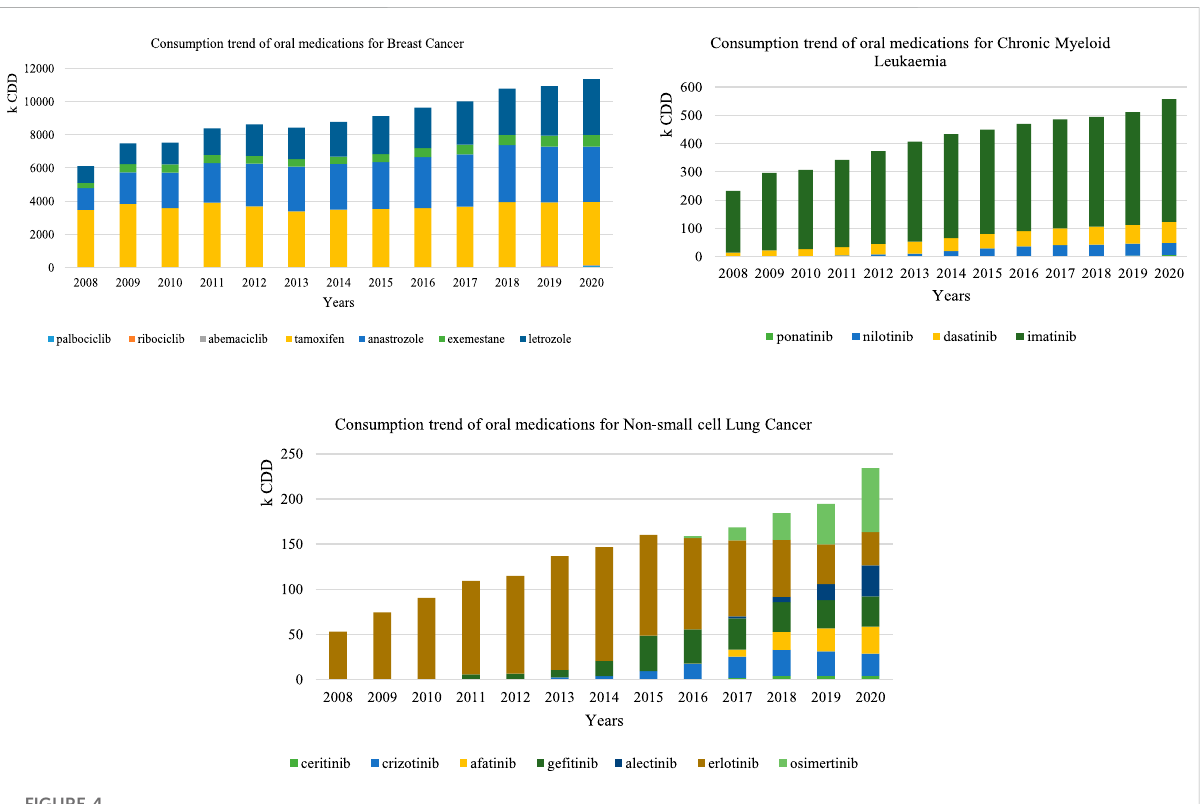
FIGURE 4 Consumption trend using the CDD of oral anticancer for breast cancer, chronic myeloid leukemia, and non-small-cell lung